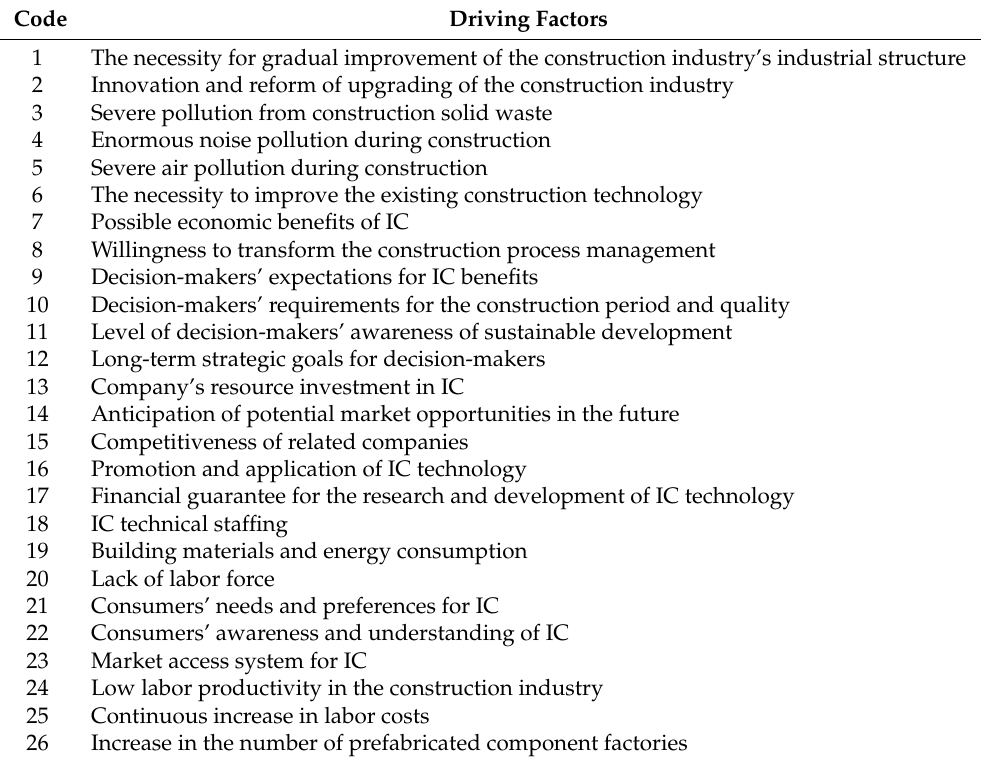
Table 2. Driving factors of IC